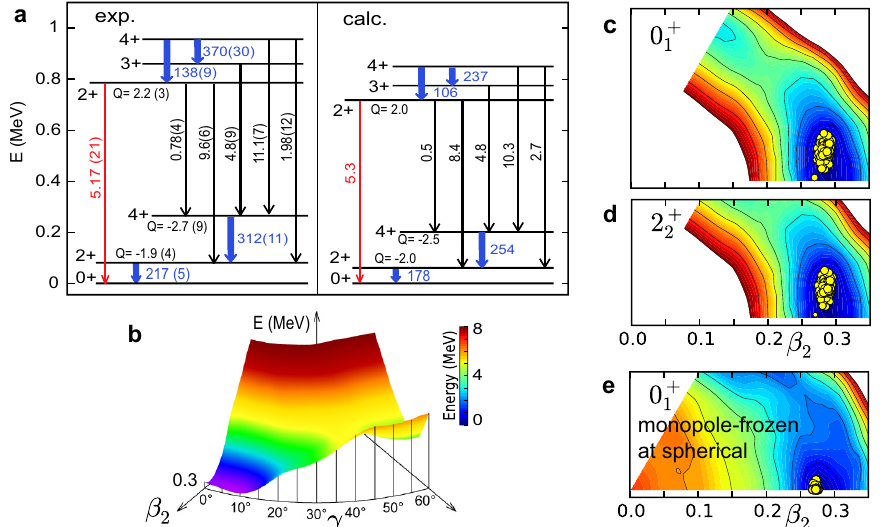
Figure 15. Experimental and calculated properties of the lowest states of 166 Er. ( a ) Energy levels and electromagnetic transitions (W.u.) [42] as well as spectroscopic electric quadrupole moments (eb) [79]. ( b ) Three-dimensional PES and its cut surface for β 2 = 0.3. ( c – e ) T-plots for the 0 + state at spherical shape. Based on Figure 4 of states and for the monopole-frozen 0 + 1